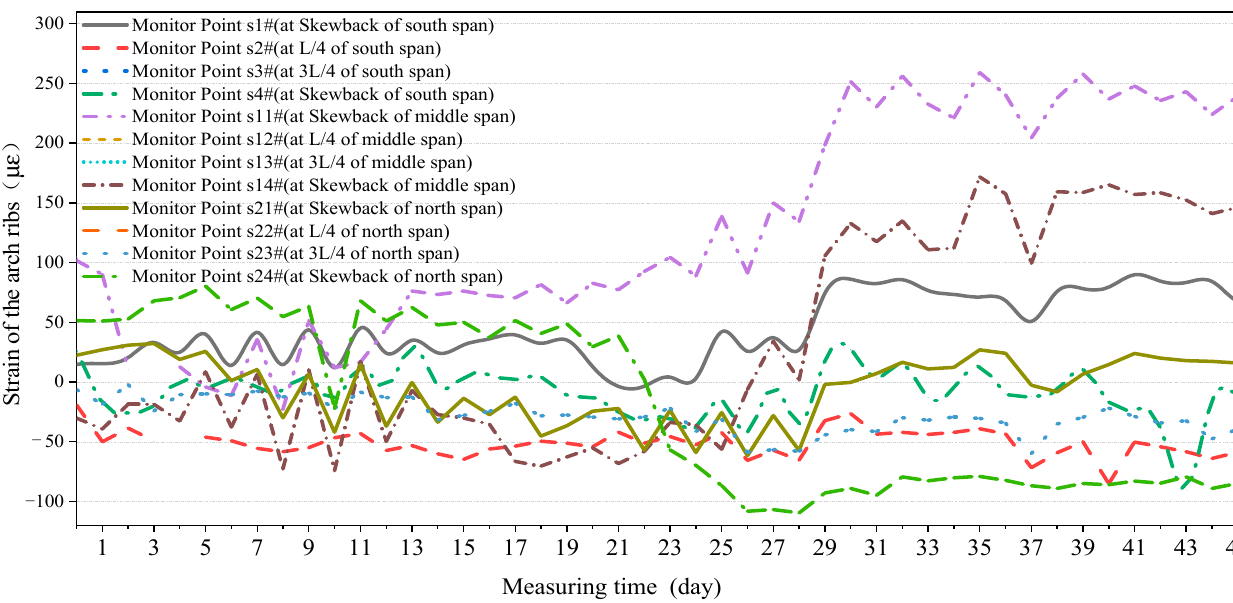
Figure 13. Monitoring results of vertical deformation of arch ribs. The monitoring results of the strain of framing scaffolding are shown in Figure 14. It can be seen from the fi gure that the strain of the framing sca ff olding is between − 50 με and 50 με during the stage of deck demolition. And the strain changes greatly in the arch rib demolition stage, but it does not exceed the strain value of 750 με ; 750 με is the strain corresponding to the allowable stress of the framing scaffolding steel.